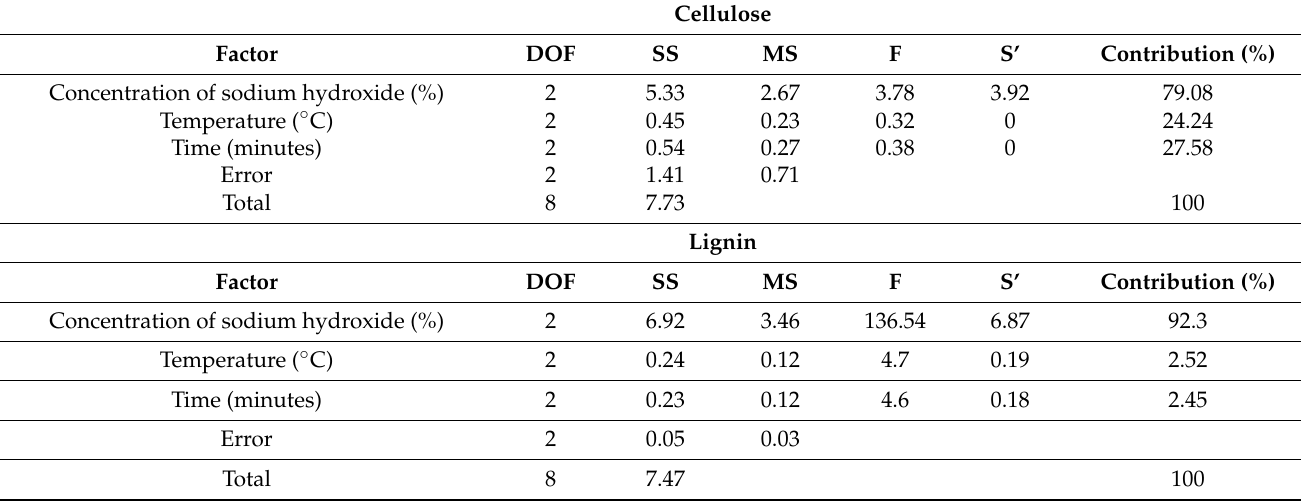
Table 3. Analysis of variance (ANOVA) of factors affecting the cellulose and lignin content.